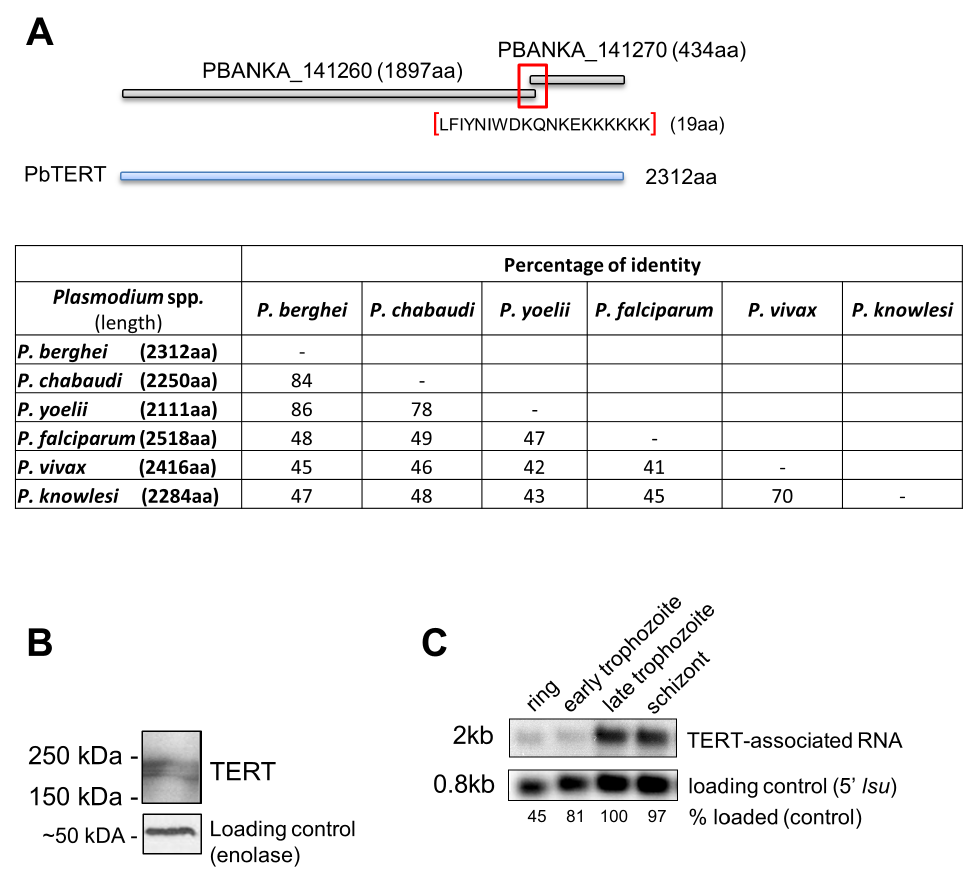
Figure 1. Pbtert gene structure (A) and PbTERT (B) and PbTR (C) expression. (A) The tert gene of P. berghei and homology (percentage identity) of TERT proteins in different Plasmodium species. Sequencing of the gap between two adjacent tert gene models available in PlasmoDB revealed a sequence duplication of 57 nt (19aa). The complete Pb tert gene encodes a protein of 2312aa, which is comparable to the size of other Plasmodium tert genes. (B) Western analysis of PbTERT protein in mixed blood stages. Two bands with a size between 150 and 250 kDa were detected (expected size of the TERT protein is , 240 kDa). (C) Northern analysis of Telomerase-associated RNA (TR) in different blood stages of P. berghei . RNA was hybridized with a probe recognizing TR (upper panel) (the expected size of TR is 2 kb) and as a loading control with a probe recognizing large subunit ribosomal RNA (expected size 0.8 kb). The ‘‘% loading’’ refers to the quantity of the loading control signal detected for each stage relative to the ‘‘late trophozoite’’ lane which is set as